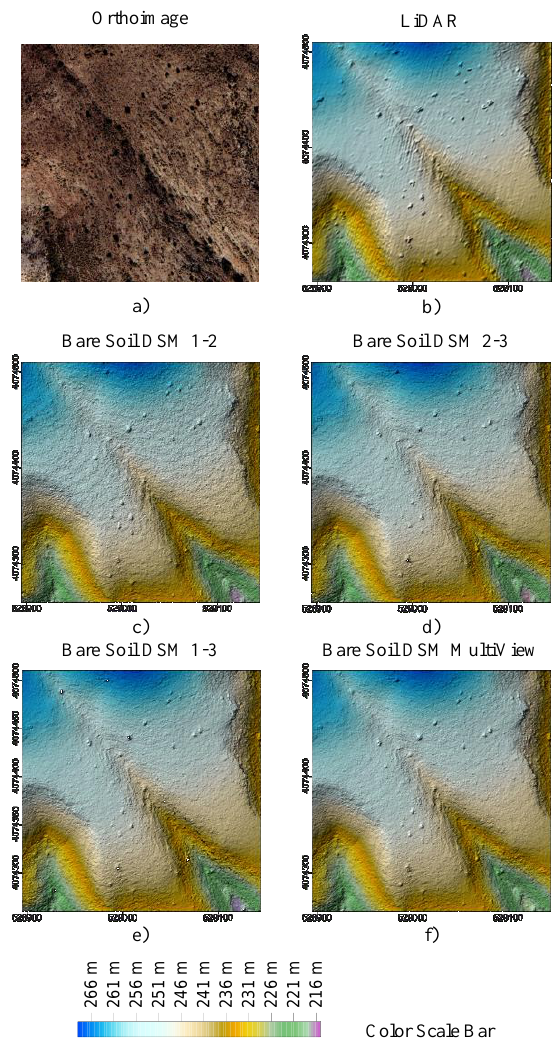
Figure 4. DSMs extracted for the bare soil land cover: a) WV3 RGB orthoimage; b) LiDAR data; c) DSM 1-2; d) DSM 2-3; e) DSM 1-3; f) DSM MultiView.